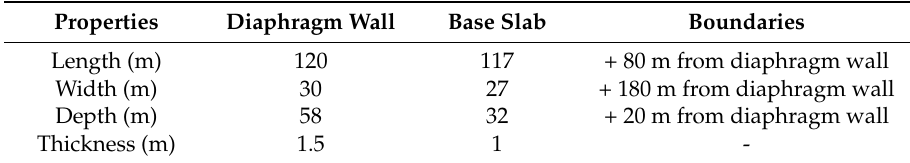
Table 2. Geometry of the metro station